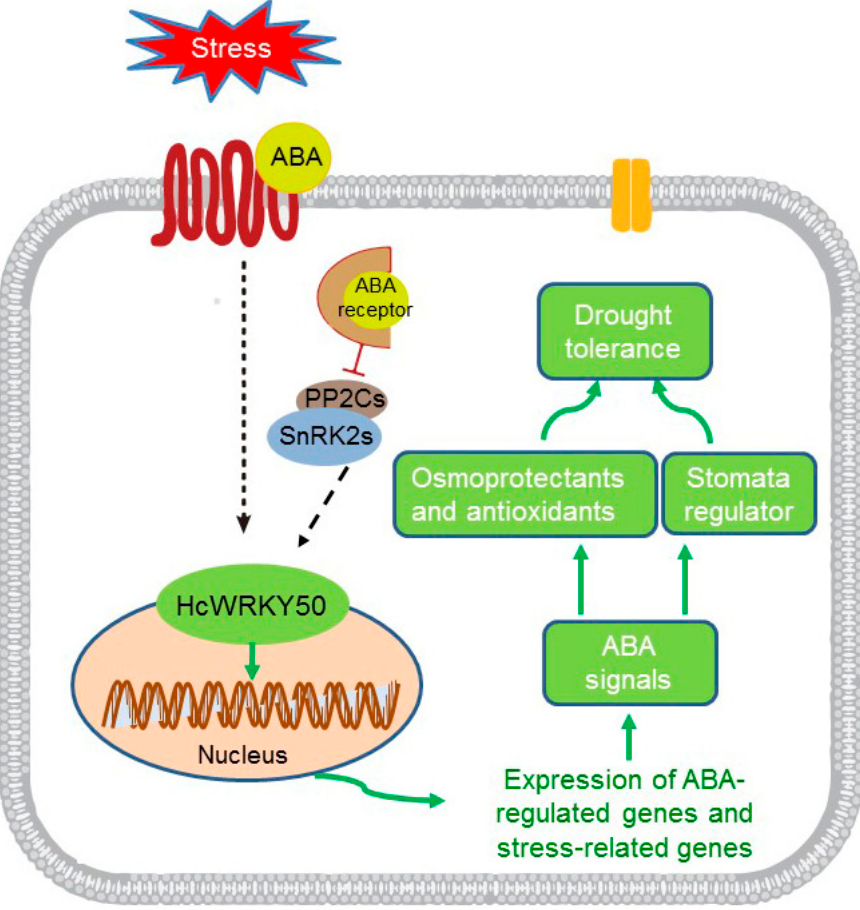
Figure 8. Proposed model for the HcWRKY50 -mediated regulation of drought stress. Upon drought stress, the ABA–receptor complex senses the stress signal and transduces the stress signal downstream. The activated HcWRKY50 then binds to promotors of the downstream target genes and triggers a signaling cascade, resulting in regulation of the expression of ABA-regulated genes and stress-related genes, altering ABA signaling and regulating osmoprotectants, antioxidants and stomata regulator to enhance drought tolerance.